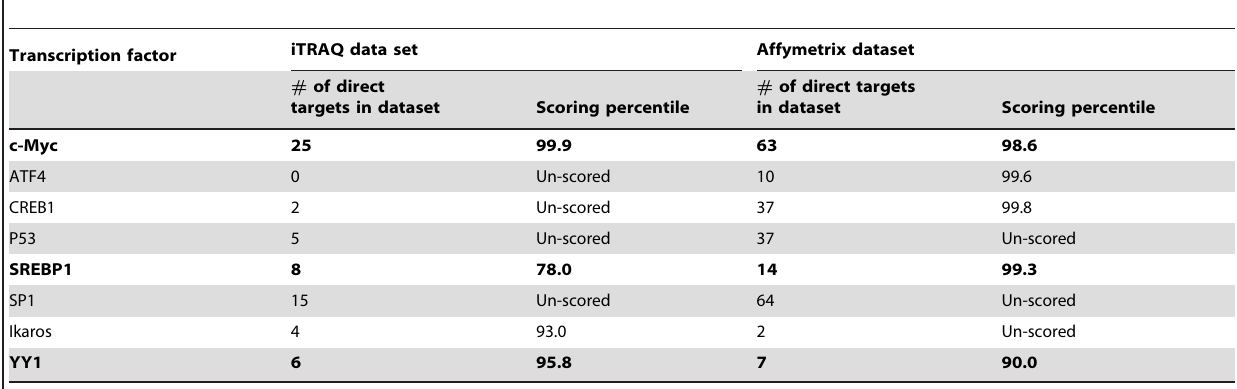
Table 1. Scoring of transcriptional regulators with significant number of direct targets among up-regulated genes and proteins.